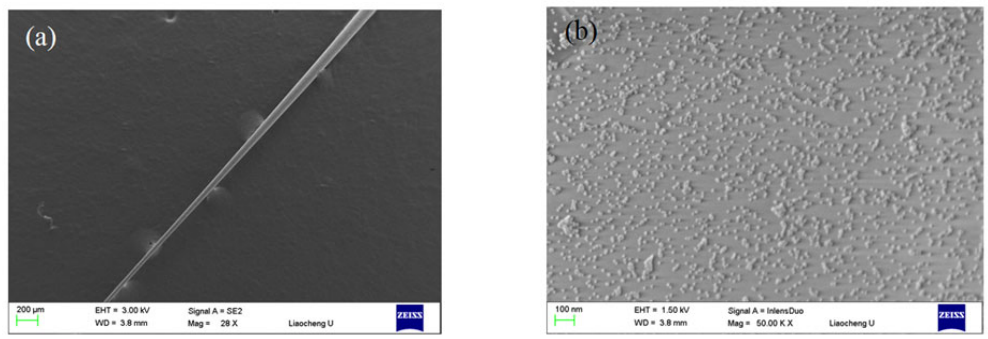
Fig. 10 SEM images of the nanoparticles-immobilized sensor probe: (a) SEM image of Probe I and (b) gold nanoparticles at the surface of the tapered fiber structure.